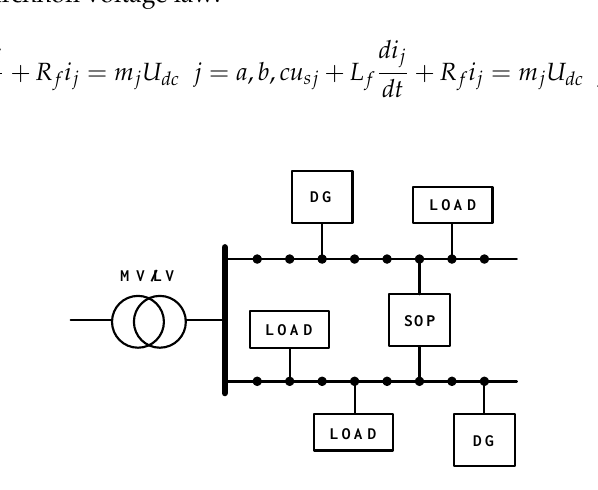
Figure 1. A typical application of soft open point.